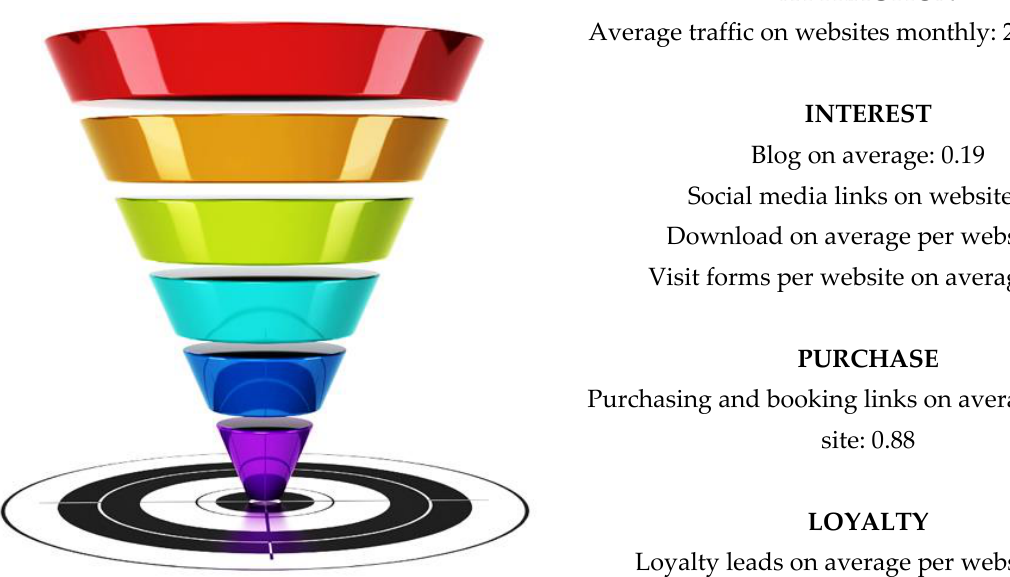
Figure 1. The Canary Islands museums conversion funnel.